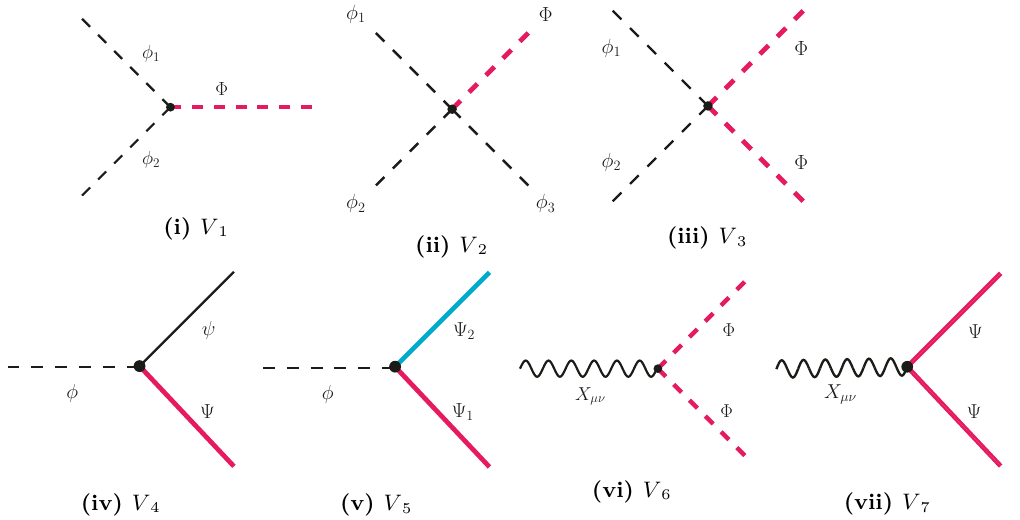
Figure 1. Vertices describing interactions between light (SM) and heavy fields. The black lines denote SM fields, whereas the pink and blue lines denote heavy fields. In V have been used to explicitly highlight the presence of two heavy